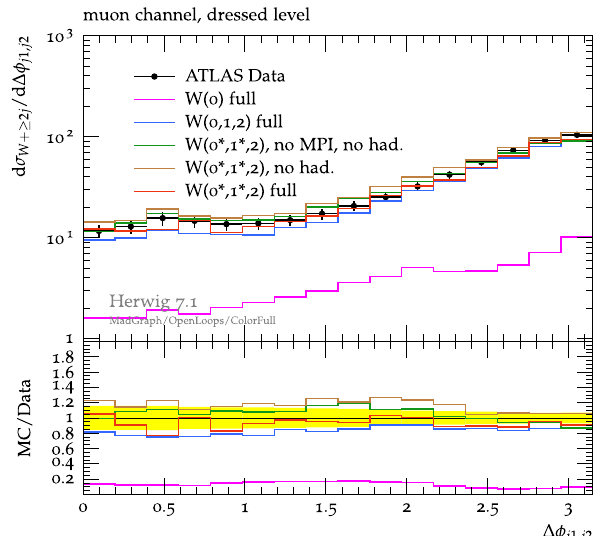
Fig. 24 Difference of the azimuthal angle between the two hardest jets in W production as measured by ATLAS [72]. ME merging is needed to describe the second additional jet and with the NLO corrections the rate of the production is improved compared to LO merging